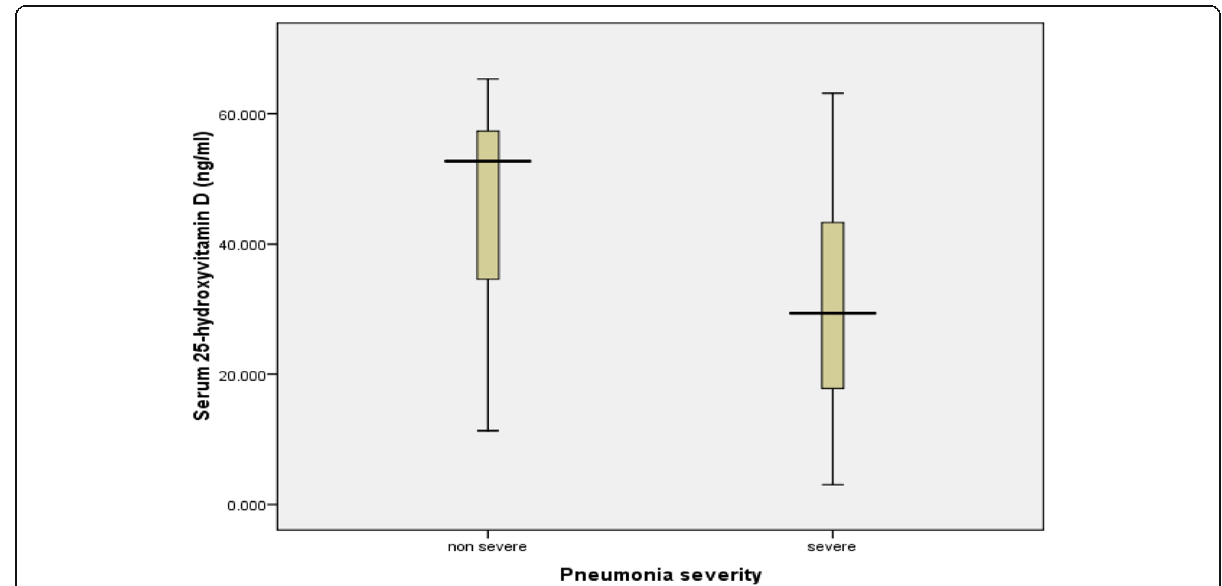
Fig. 1 Boxplot of serum vitamin D and pneumonia severity